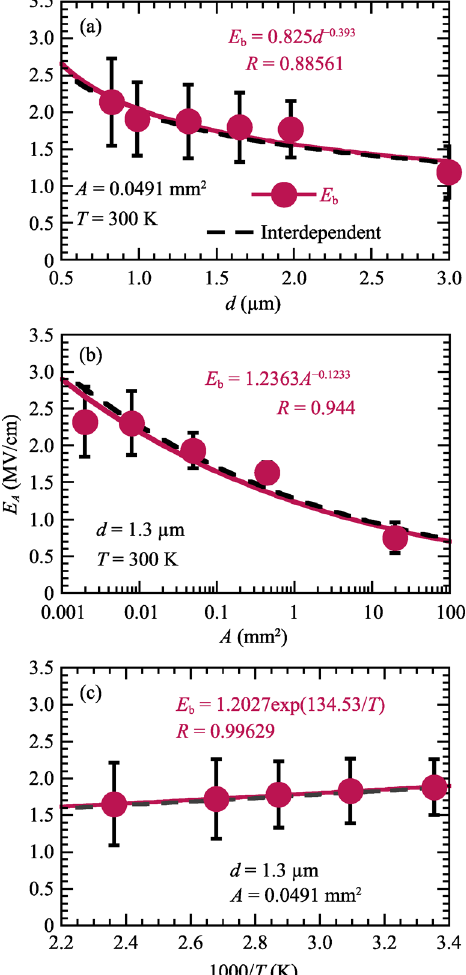
Fig. 3 Average dielectric breakdown electric field ( E A ) of PLZT films as function of film thickness (a), electrode area (b), and temperature (c). Solid red curves represent the fits with Eqs. (3) and (6); broken black curves represent the fit using the unified Eq. (7).